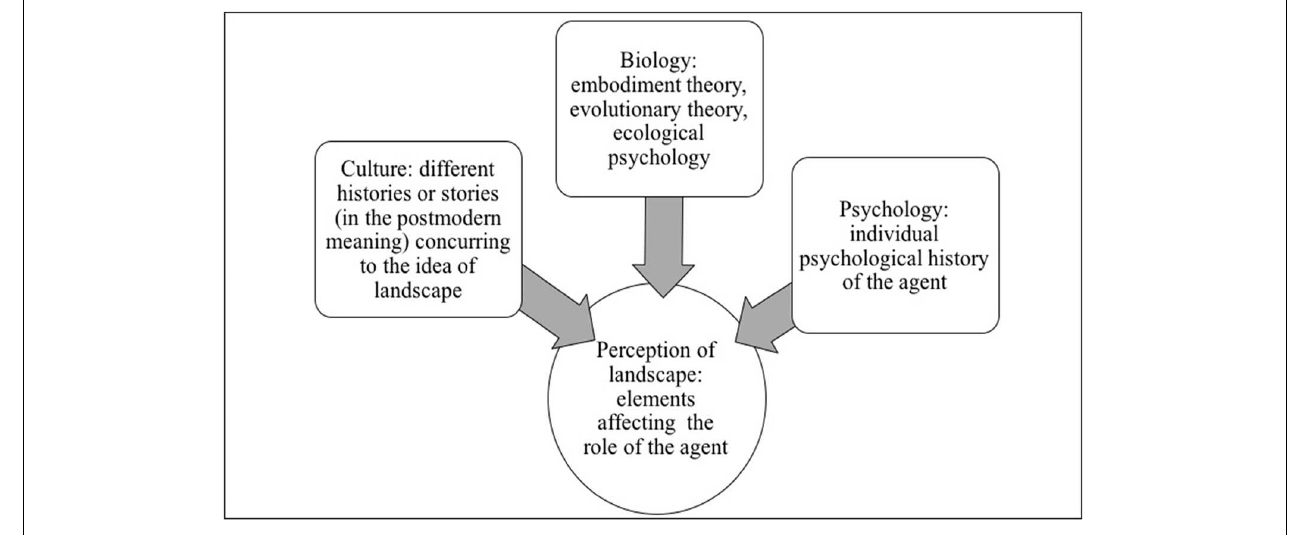
FIGURE 1 | Perception of landscape.